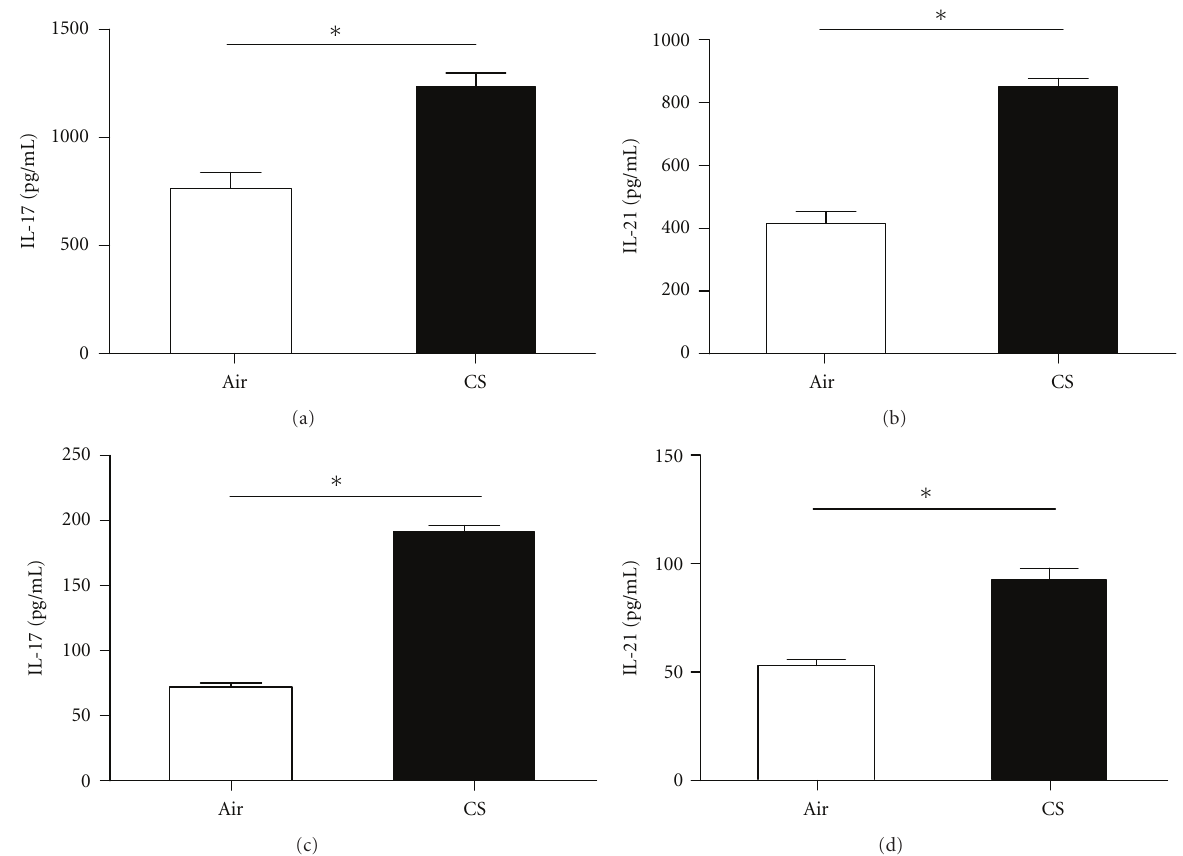
Figure 2: Protein levels of Interleukin- (IL-) 17 and Interleukin-21 (IL-21) in lungs and peripheral blood of air- and CS-exposed mice at 24 weeks by using ELISA. (a) Protein levels of IL-17 in lungs, (b) protein levels of IL-21 in lungs, (c) protein levels of IL-17 in peripheral blood, and (d) protein levels of IL-21 in peripheral blood. Results are expressed as pg/mL (mean ± SD). n = 10 animals/group; ∗ P < 0 .